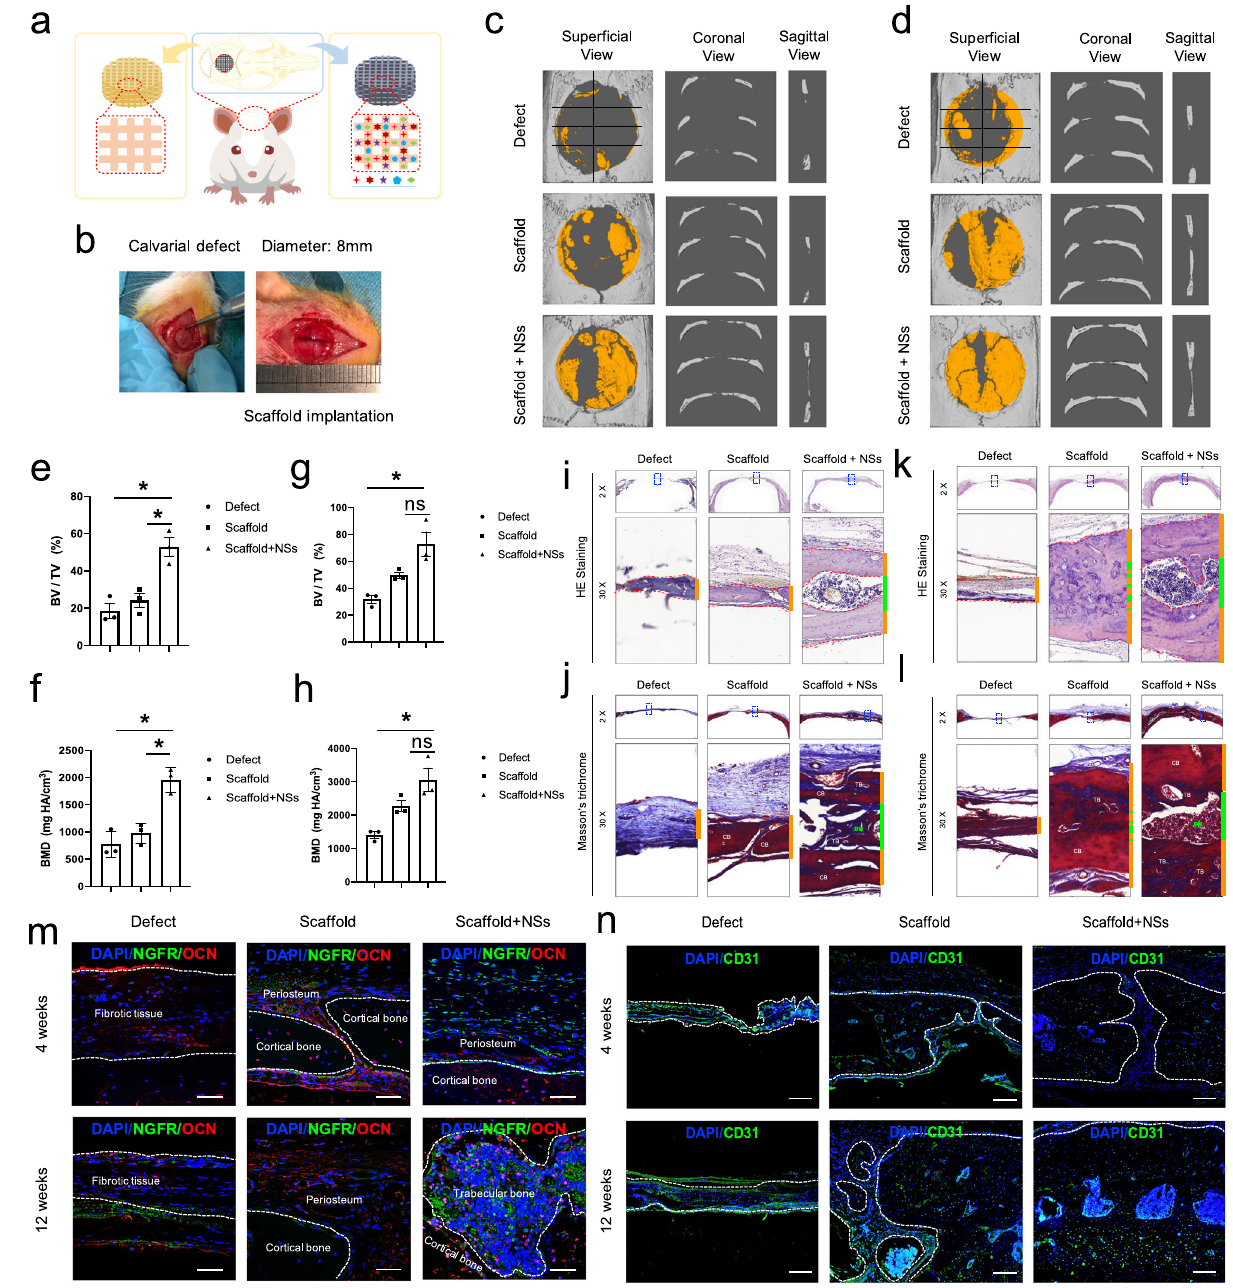
Fig.2|Transplantationofthe3DprintedhydrogelscaffoldwithNSspromotes rapid regeneration of critical-sized calvarial defect. a, b Illustration of the implantation of NSs-loaded 3D printing gel scaffold before and after calvarial defect surgery. c , d μ -CT evaluation of bone regeneration in Defect control (Defect), 3D printed scaffold (Scaffold), 3D printed scaffold containing NSs (Scaffold+NSs)groupsat4weeksand312weekspost-surgeryofcalvarialdefect (the yellow area indicates new bone formation), respectively. n =3 rats for per group and per time point. e Bone volume fraction (BV/TV) (Exact p value cal- culated with one-way ANOVA Tukey ’ s multiple comparisons test: * p =0.0218, * p =0.0391); and f Bone mass density (BMD) (Exact p value calculated with one- way ANOVA Tukey ’ s multiple comparisons test: * p =0.0113, * p =0.0214) of regenerated tissues in defect area at 4 weeks after calvarial defect. g Bone volume fraction (BV/TV) (Exact p value calculated with one-way ANOVA Tukey ’ s multiple comparisons test: ** p =0.0076, p =0.0532); and h Bone mass density (BMD) (Exact p value calculated with one-way ANOVA Tukey ’ s multiple